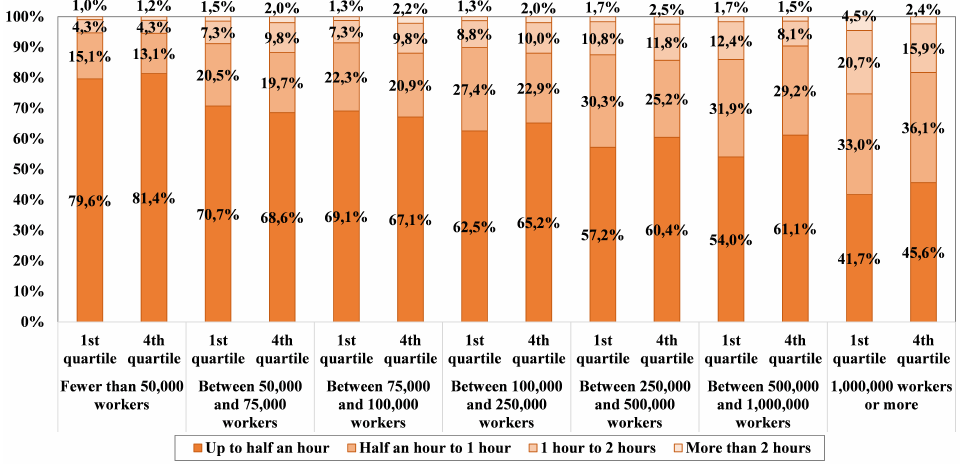
Figure 2: Distribution of workers who commute from home to work and belong to the 1st and the 4th quartile of the wage distribution, according to their commuting time and the size of the workforce in the municipality of residence,